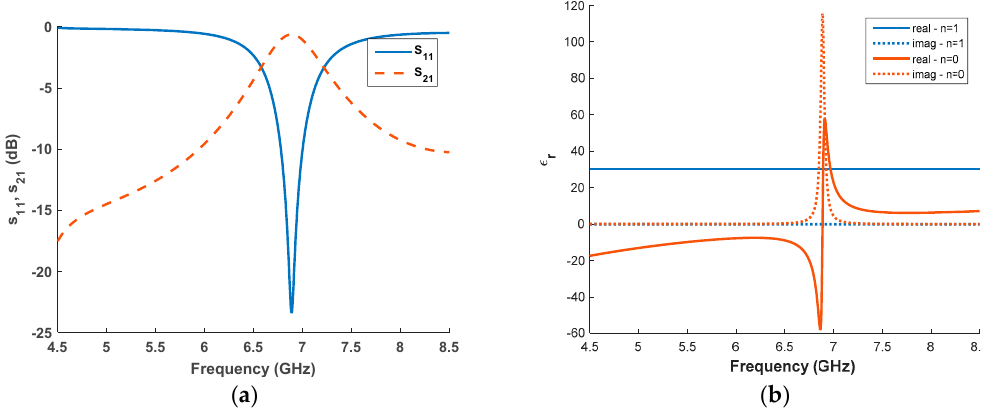
Figure 6. ( a ) Scattering parameters for a sample of ε r = 30 − j0.2, µ r = 1 − j0 with d = 8 mm; ( b ) estimated dielectric permittivity for n = 0 and n = 1.